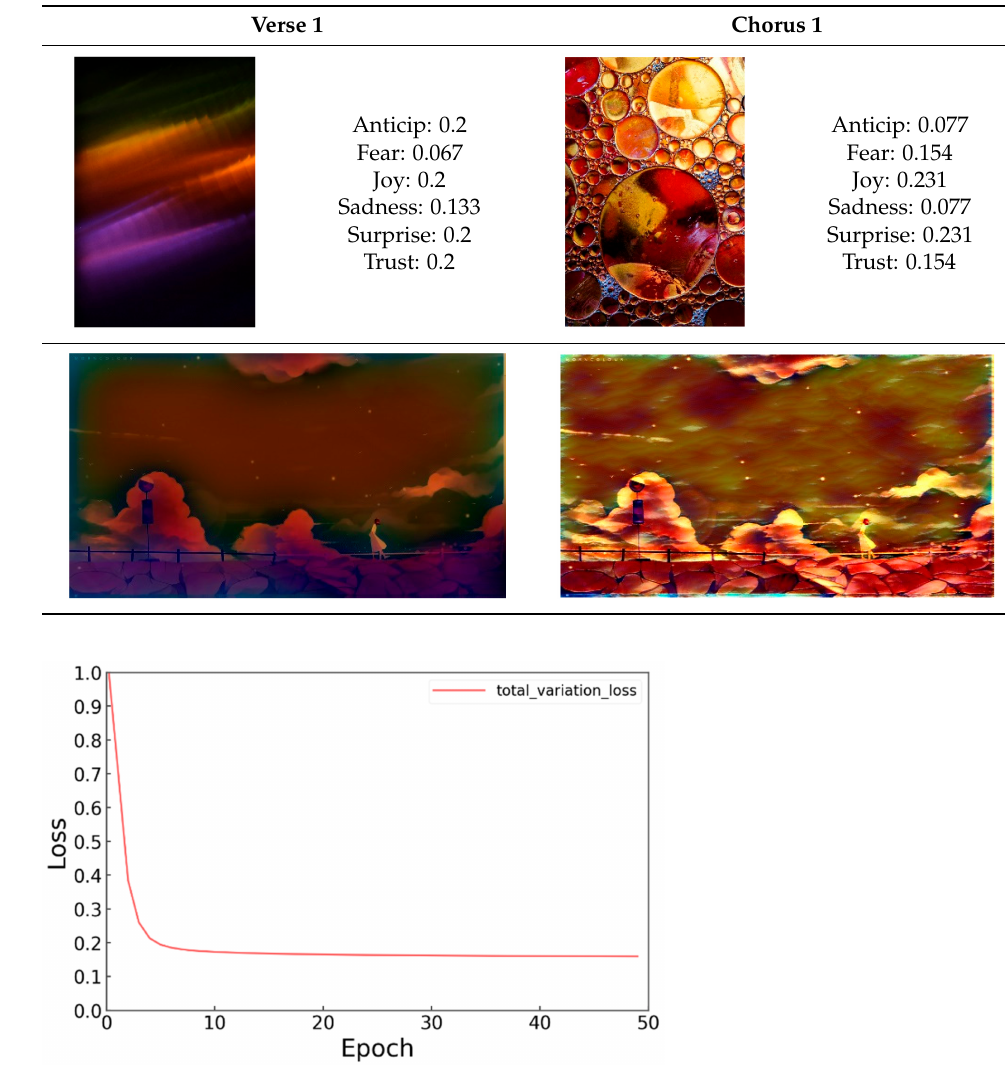
Figure 12. Total variation